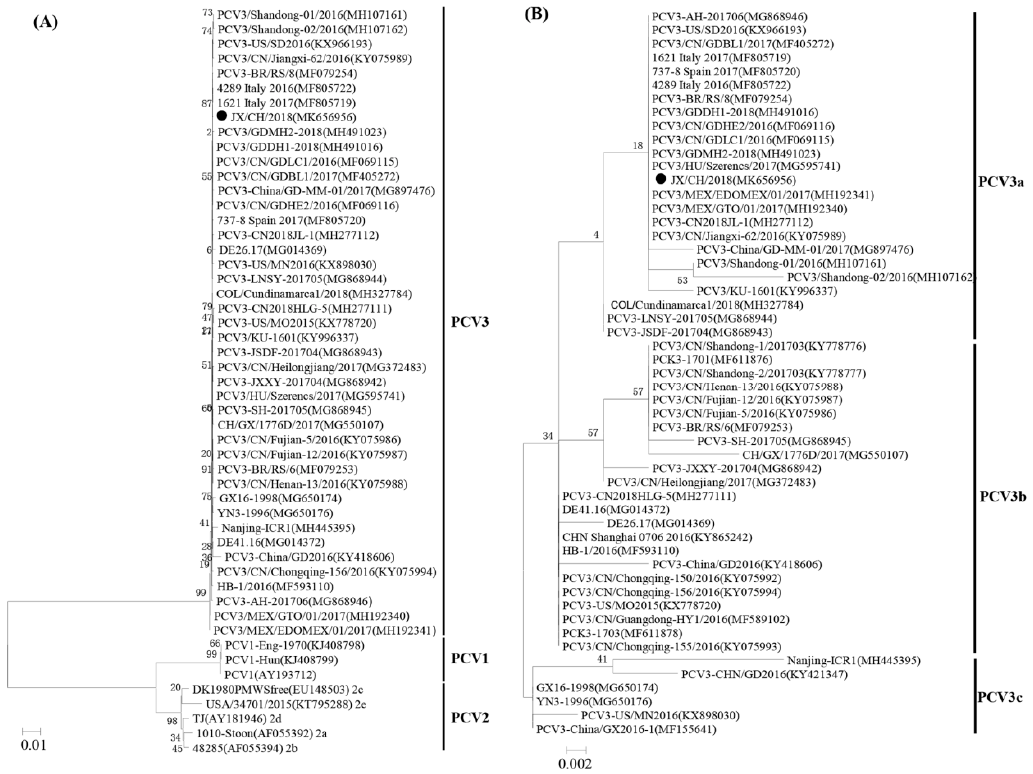
Figure 2. Phylogenetic trees generated based on the complete genome sequence of PCV3, PCV2, and PCV1 ( A ) and capsid protein sequences of PCV3 around the world ( B ). Bootstrap values were calculated with 1000 replicates. A bar of 0.002 indicates nucleotide or amino acid substitutions per site. “ ● ” indicates the strain identified in this study.